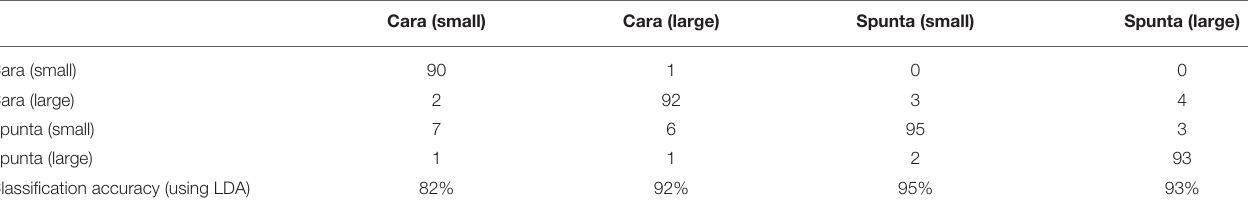
TABLE 5 | Classification results, confusion matrix and classification accuracy, for evaluating potato tuber size using a colour imaging system. Cara